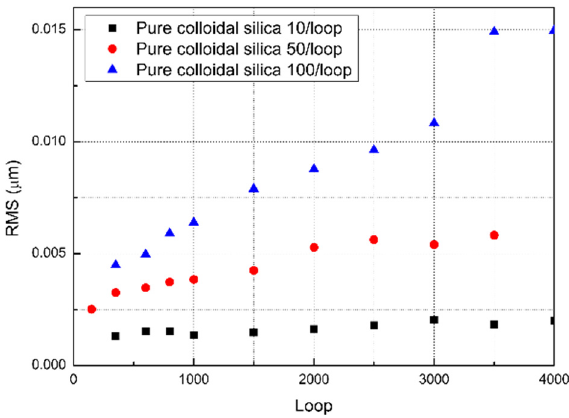
Figure 6. Simulated RMS roughness by pure colloidal silica with 10, 50, and 100 abrasives per loop. First, Gaussian blur over the entire surface was adopted for continuous scratching. The size of the symmetric Gaussian low-pass filter is linear to the contact circle radius 𝑎 (cid:3036) of each effective abrasive for the initial scratch. The standard deviation of the filter is de- termined by its linear relationship with the square root of the deformation depth 𝑑 (cid:3036) . The scratch evolution is shown in Figure 7 for 101 loops.